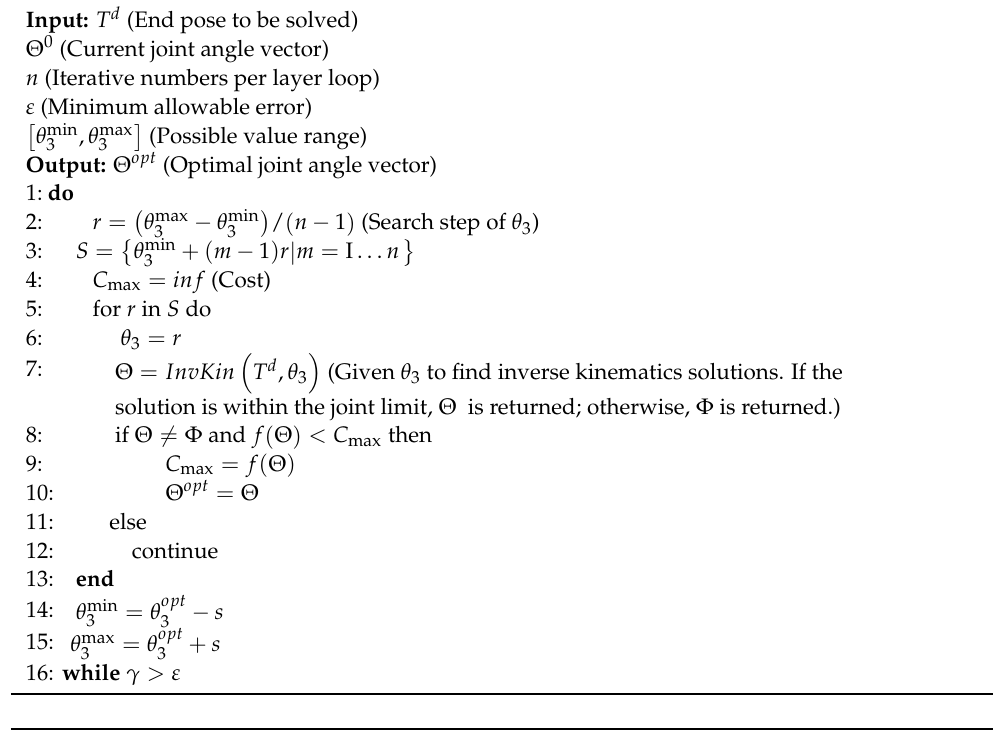
Algorithm 1: According to the Cost Function (7), the Obtained Optimal Solution θ